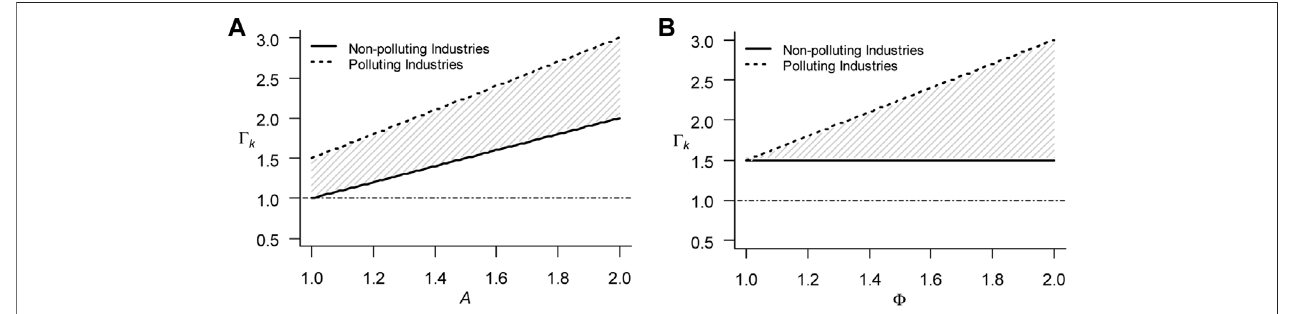
FIGURE2| Simulationresultsofheterogeneityimprovementsof fi rmproductivity. Note :Thesolidlines(dashedlines)inthe fi gurerepresenttheheterogeneityofthe productivityofnon-pollutingindustries(pollutingindustries)inthewesternandcentralregions,andtheshadowsrepresent theheterogeneitybetweenpollutingandnon- polluting industries. In addition, loose environmental regulation parameter Φ (cid:1) 1 . 5 in (A) and policy advantage parameter A (cid:1) 1 . 5 in (B)